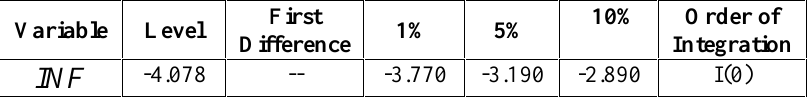
Table 4: Dickey-Fuller GLS Unit Root Test